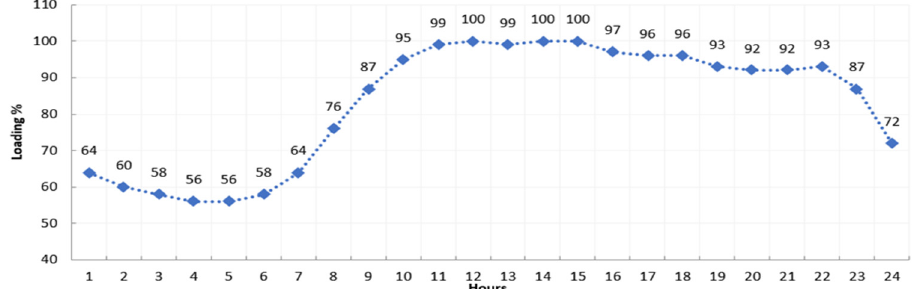
Figure 6. Daily load demand profile.